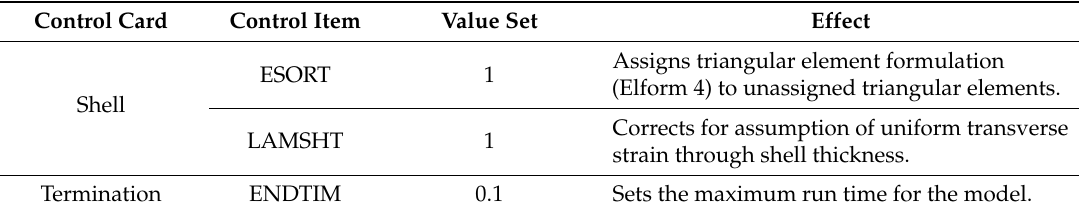
Table 4. Parameters for control section of model.